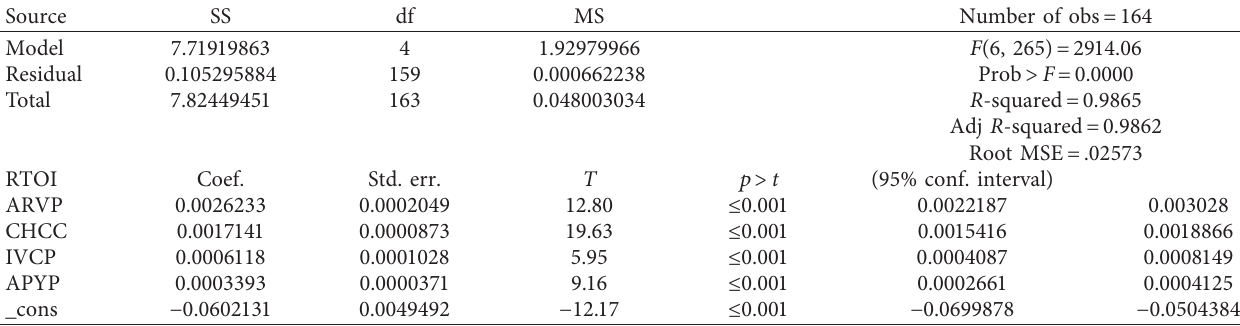
Table 5: Regression result model two